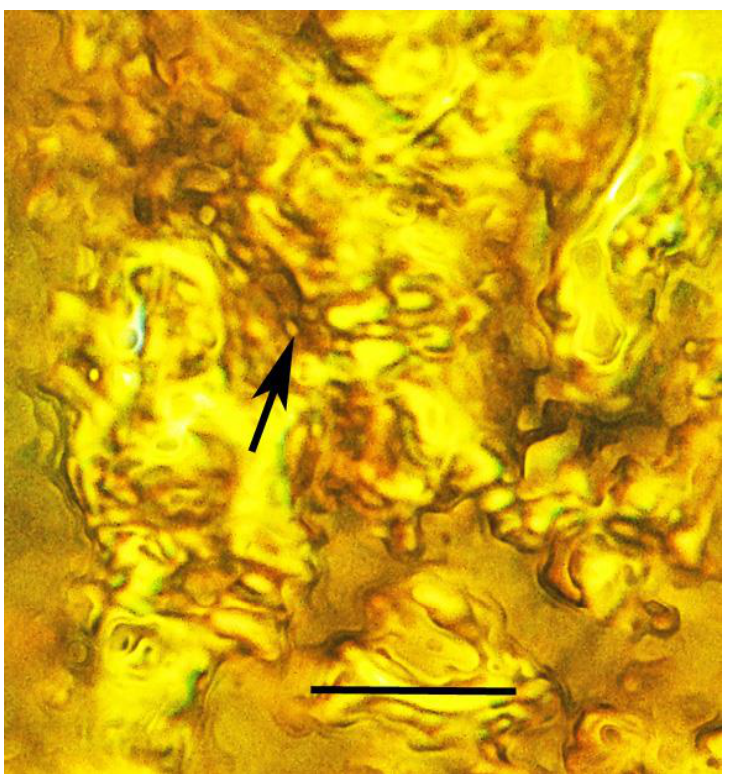
Figure 24. Portion of the femoral mycetangium of Palaeotylus femoralis (Coleoptera: Curculionidae: Platypodinae) showing hyphal fragments and yeast-like propagules (arrow) of the ambrosia fungus, Paleoambrosia entomophila (Ophiostomatales: Ophiostomataceae) in Burmese amber. Scale bar = 14 µm.